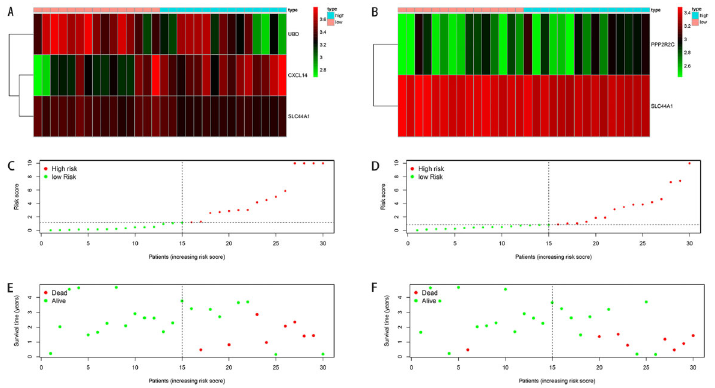
Figure 5. Risk score analysis based on the gene signature in the head and neck carcinomas (HNC) group. A , C , and E : Disease-speci fi c survival (DSS); B , D , and F : progression-free survival (PFS). A and B : Heatmap of UBD, CXCL14, SLC44A1, and PPP2R2C expression in HNC samples. The colors from green to red indicate the expression level from low to high. C and D : Patient survival status and time distributed by risk score. The dotted line indicates the individual in fl ection point of the risk score curve, by which the patients were categorized into low-risk and high-risk groups. E and F : Risk score curve of the autophagy signature. The green dots represent patients who are alive and the red dots represent patients who have died.